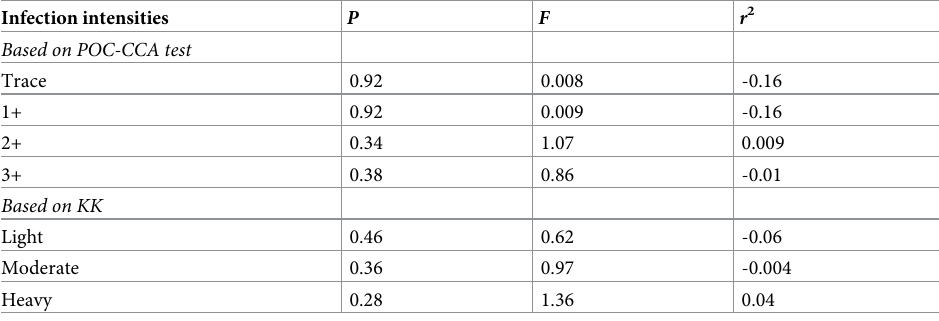
Table 6. Correlation coefficients between the mean distances of schools to the nearest water points and the infec- tion intensities of S . mansoni .